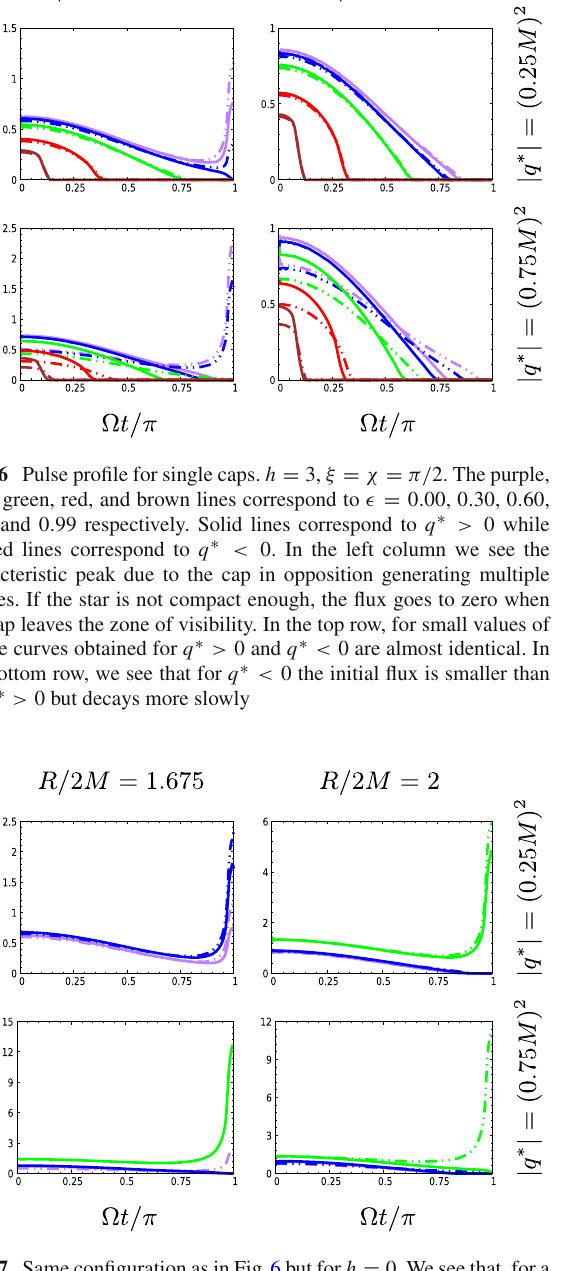
radius of the star, the greater its relative luminosity at (cid:2) t = 0. This is because, being less compact, the trajectories of the light rays are less disturbed by the gravitational field, so they are not so strongly deflected and more of them manage to reach the observer. At the same time, increasing the radius decreases the portion of the period during which the cap is visible.